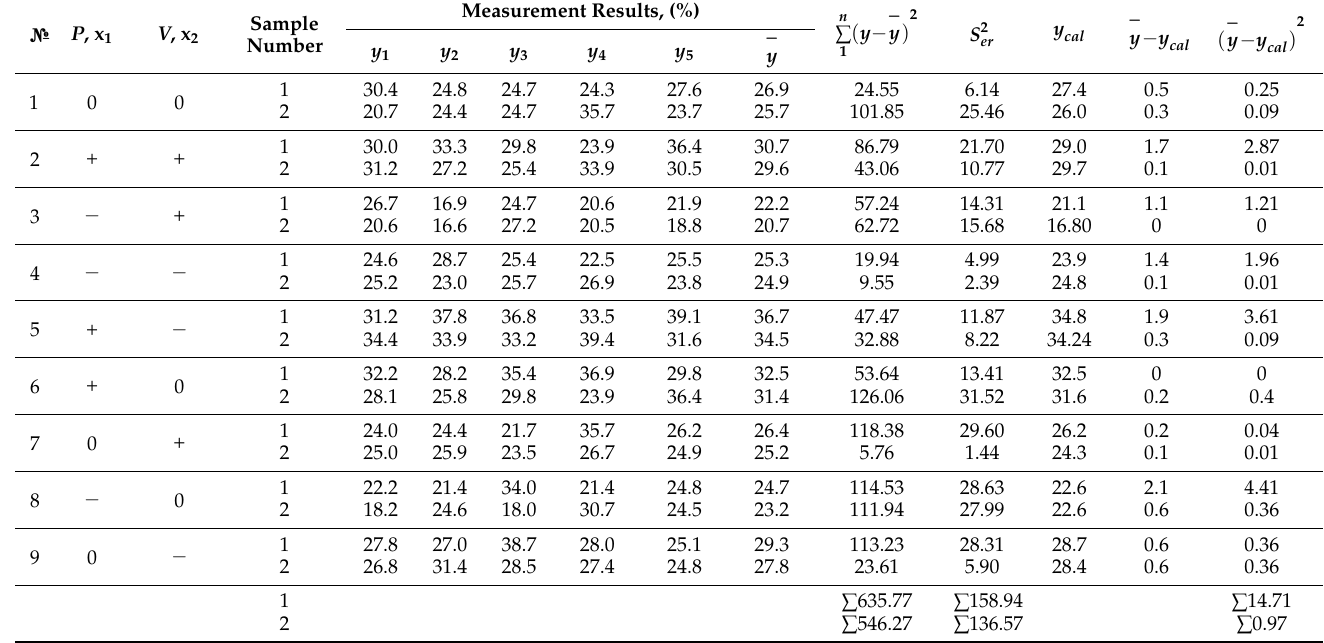
Table 1. Experimental processing